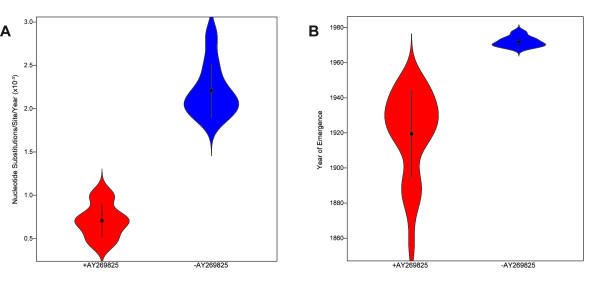
Violin plots displaying AY269825’s influence on estimated substitution rates (A) and years of emergence (B) for RHDV. Both plots are based on the mean rates and TMRCA from the VP60 jackknife analysis results. For each plot, datasets represented on the left included AY269825 (“+AY269825”), while datasets represented on the right did not (“-AY269825”). Black rectangles and lines indicate the arithmetic mean and standard deviation of each group of data, respectively, while the shading demonstrates the probability density of each group.